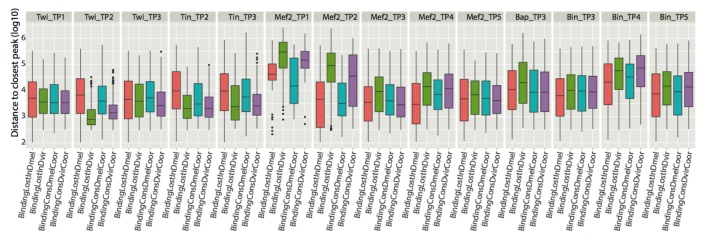
Boxplots represent the distribution of distances to closest peaks (in logarithmic scale) for each of the 14 conditions assayed.The distribution of distances of a TF binding event lost in D. mel (BindingLostInDmel) at the indicated condition (i.e. Twi_TP1) to the closest peak for the identical condition in another CRM. Similarly, BindingLostInDvir shows the distance distribution of a TF binding event lost in D. virilis at the indicated condition to the closest peak for the identical condition in another CRM. BindingConsDmelCoor shows distance distribution for D. melanogaster CRMs that have their binding conserved and similarly for BindingConsDvirCoor..